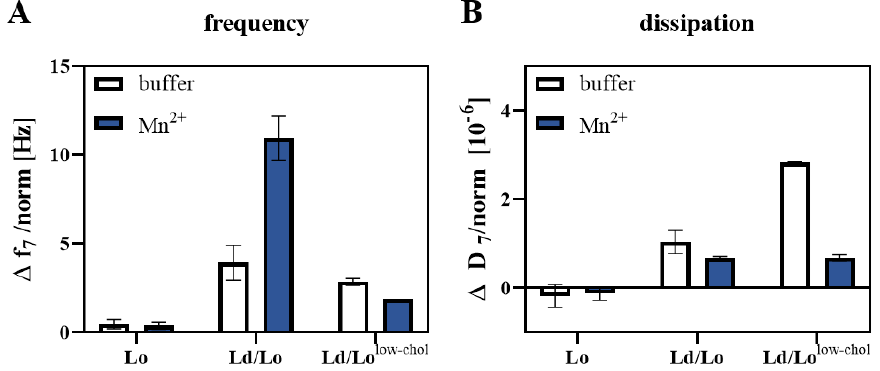
Figure 6. Activation of integrin α IIb β 3 reconstituted in lipid environments of different lipid compositions. The integrin conformation was observed by monitoring the binding of the conformation- specific antibody PAC-1 by QCM-D. DOPC:SM:cholesterol proteoliposomes comprising different ratios of lipids as indicated, were injected on a SiO 2 surface. Vesicle fusion was initiated by 13 µ M AH- peptide. Formed bilayers were equilibrated with 25 mM HEPES, pH 7.4, 150 mM NaCl, 1 m CaCl 2 , with or without 1 mM MnCl 2 for at least 30 min at 37 ◦ C. Afterwards, PAC-1 antibody (5 µ g/mL) was injected for 10 min, followed by rinsing with the respective buffer. Changes in oscillation frequency ∆ f ( A ) and energy dissipation ∆ D ( B ) upon PAC-1 injection in QCM-D experiments are shown. Results correspond to two independent measurements ± SEM. Changes in f and D are normalized to the respective integrin concentration determined by SDS-PAGE. Results for bare liposomes are represented in Figure